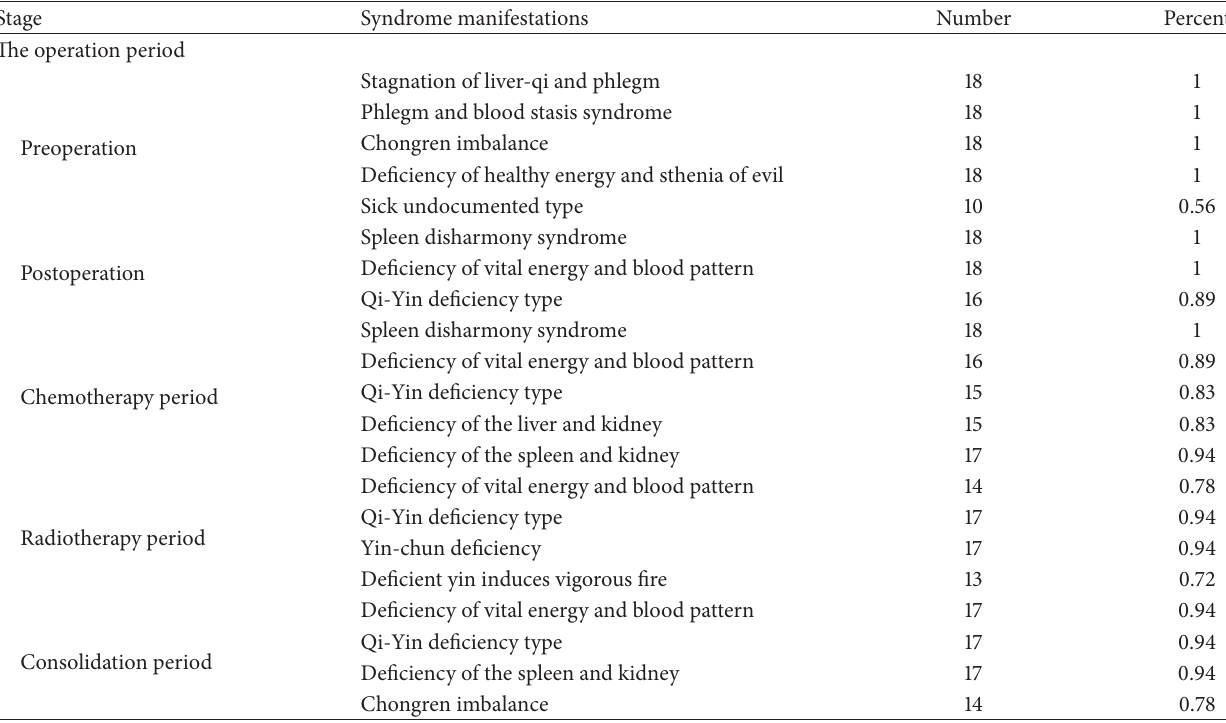
Table 1: The experts’ opinion on the classification of treatment phase and syndrome differentiation in the first round. Stage